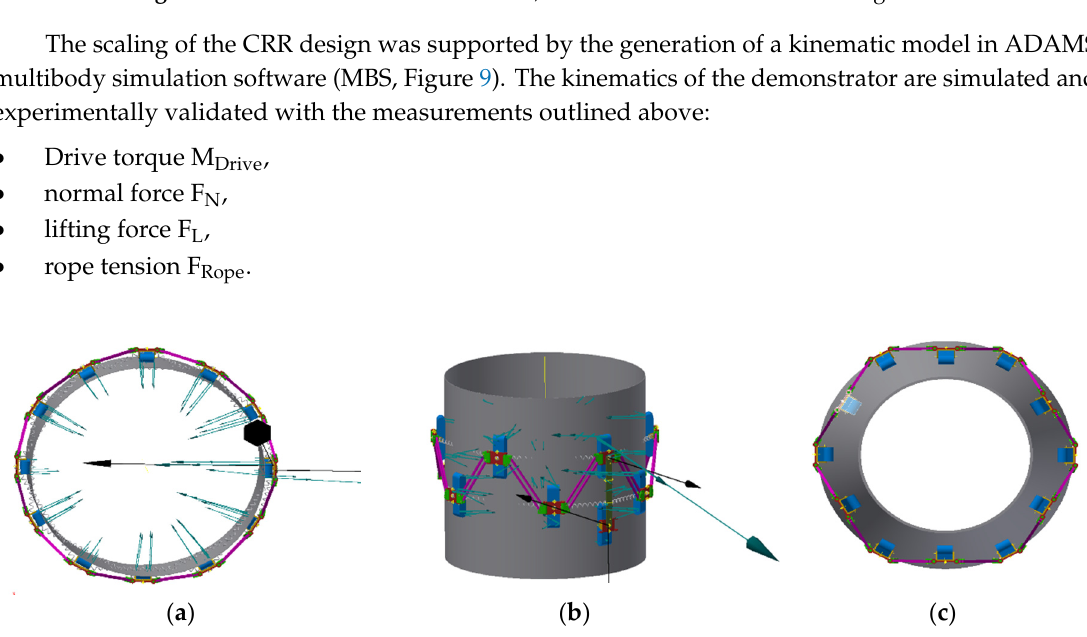
Figure 8. Front-view of the CRR crawler; arrows indicate circular tower alignment.